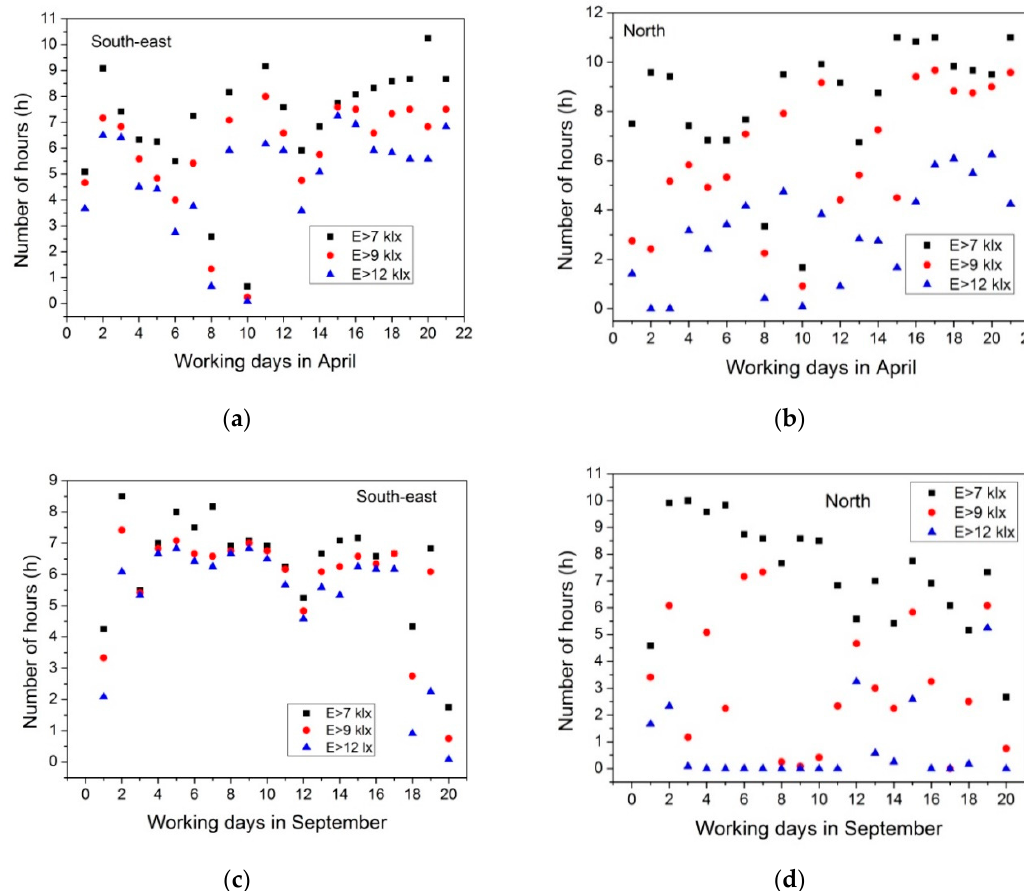
Figure 8. Number of hours in which the illuminance level outside the building exceeded the value of 7, 9, and 12 klx, on working days in April, from the south-east ( a ) and the north ( b ), and in September, from the south-east ( c ) and the north ( d ).